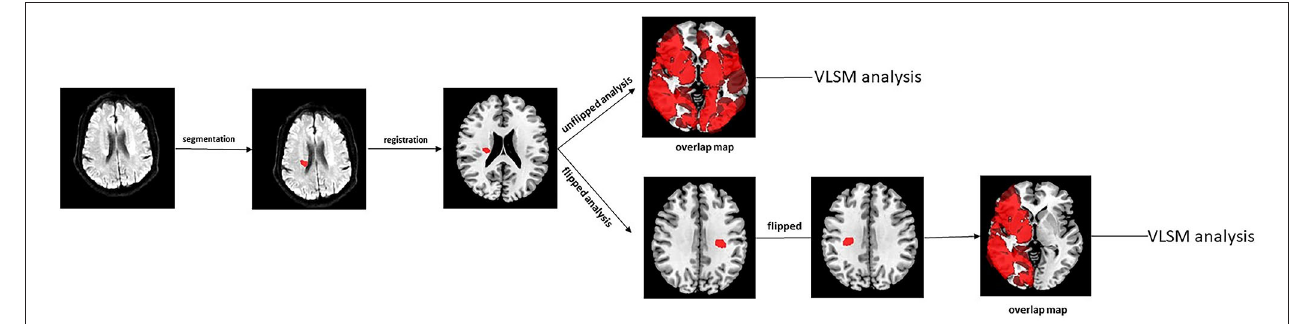
FIGURE 1 | The flow chart of image preprocessing procedures for VLSM analysis. VLSM, voxel-based lesion-symptom mapping.